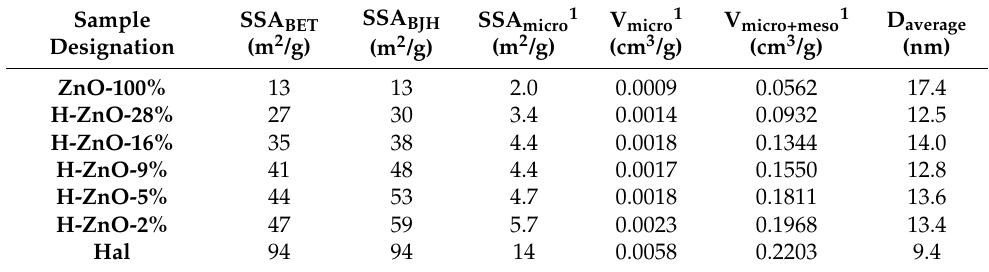
Table 2. Specific surface area (SSA), pore-volume (V), and pore-size (D)